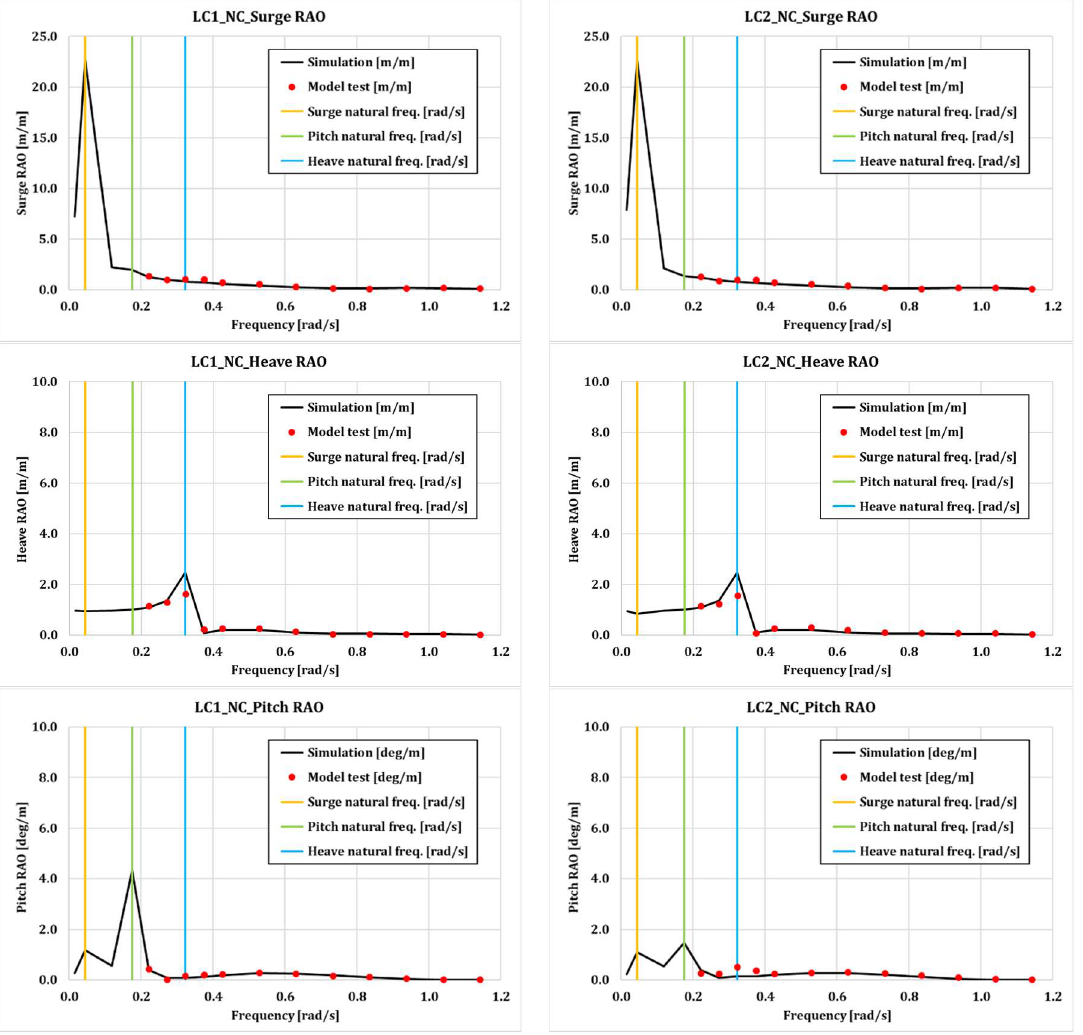
Figure 13. Response amplitude operator ( RAO) for the surge, heave, and pitch motions of a platform without current.